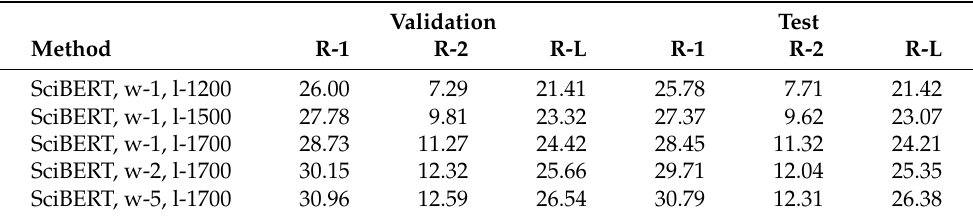
Table A6. Fine-tuning for PubHealth supervised multi-task model over positive sentence loss weight, base model and maximum length.